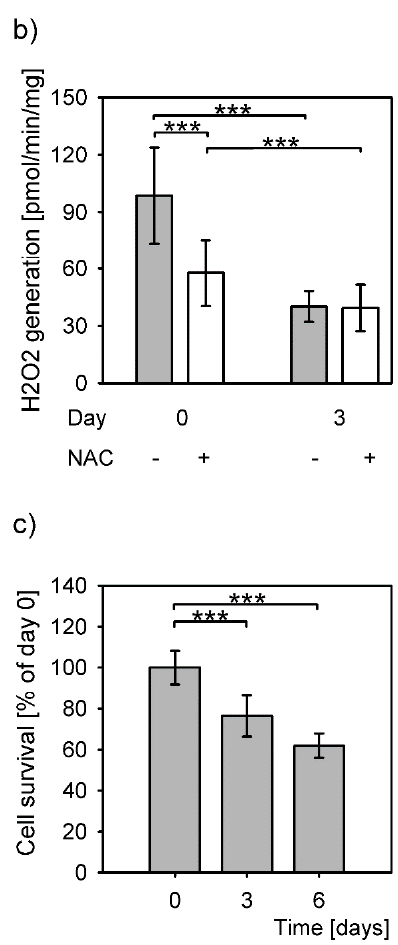
SD. SD. ± ± 10 − 15 , Kruskal-Wallis rank 10 − 15 , Kruskal-Wallis × ×